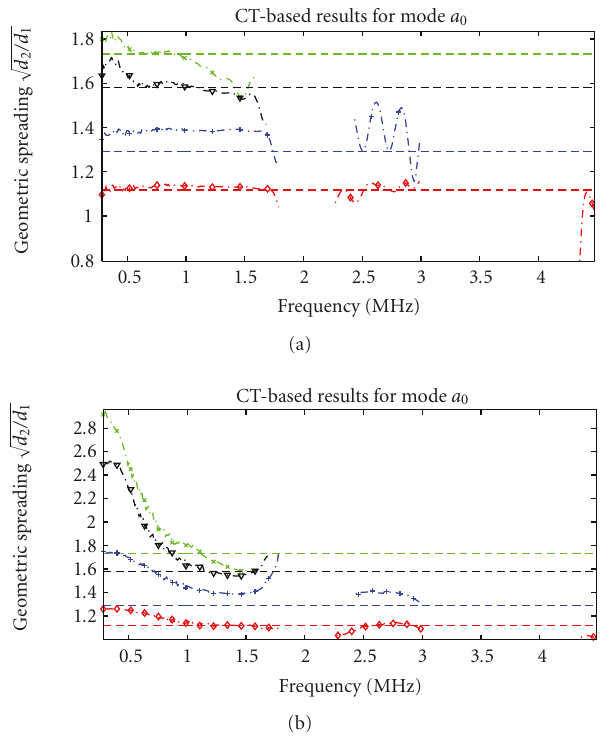
Figure 4: Geometric attenuation for the a 0 -mode of the experimen- tally generated signal determined with the STFT (b) and CT (a). Dashed lines represent the theoretically expected solution dash-dotted lines are the results obtained from the CT- and STFT- based algorithm, respectively, for the distances 50 mm (green), 60mm (black), 90 mm (blue), and 120 mm (red) related to 150 mm of propagation